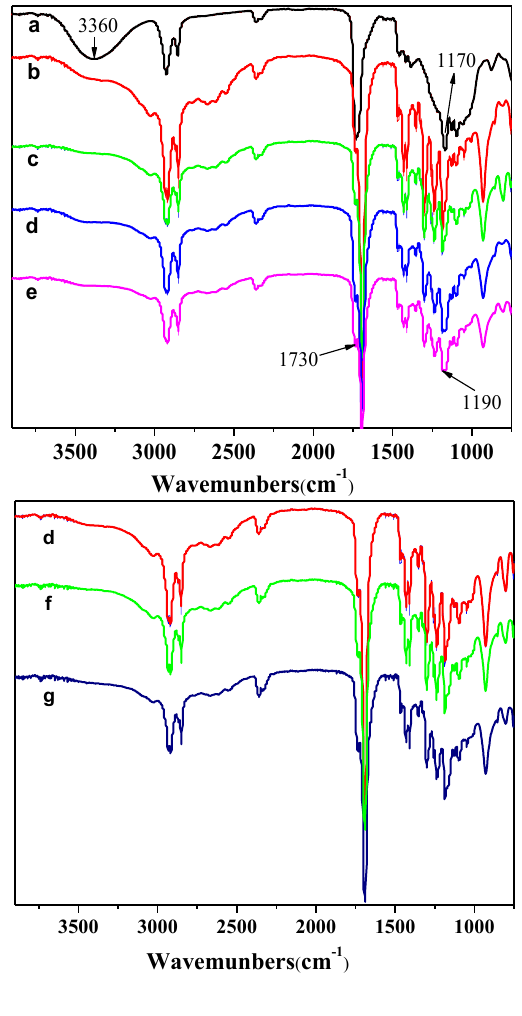
Figure 2. FT-IR characterization of the poly(xylitol glutamate sebacate) (PXGS): ( a ) PXGS 1:1-5%; ( b ) PXGS 2:3-5%; ( c ) PXGS 1:2-5%; ( d ) PXGS 2:5-5%; ( e )